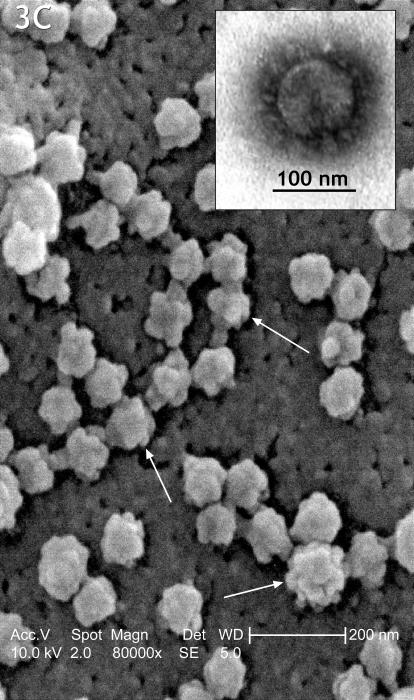
Scanning Electron Micrograph Showing the “Rosettelike” Appearance of the Matured SARS-CoV (Coronavirus) Particles (Arrows)This scanning electron micrograph emphasizes the form and structure of the virus particle, or virion, made visible with negative staining (inset) under transmission electron microscopy. Short and stubby spikes are visible on the virus surface.(Photo: CDC/Mary Ng Mah Lee, National University of Singapore, Singapore)